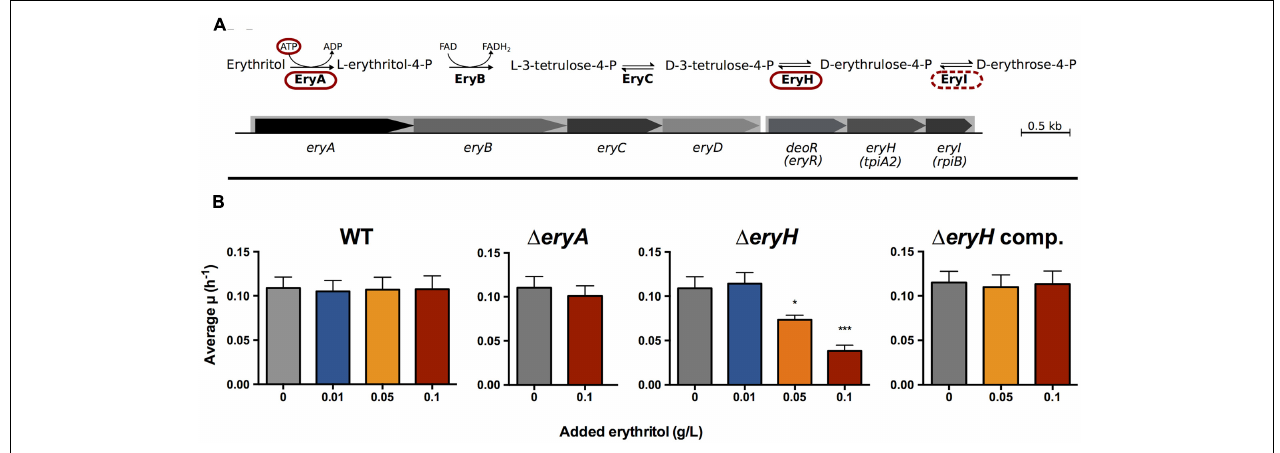
FIGURE 1 | Brucella abortus (cid:49) eryA and (cid:49) eryH are erythritol-tolerant and erythritol-sensitive. (A) Revised erythritol catabolic pathway (the mutants used in this investigation are circled); (B) Growth of B. abortus 2308 WT, (cid:49) eryA , (cid:49) eryH and complemented (cid:49) eryH mutants in 2YT medium supplemented with increasing concentrations of erythritol. Values are the average of biological and technical triplicates plus the standard deviation ( ∗ p < 0.05; ∗∗∗ p < 0.001 [Student’s t -test]).